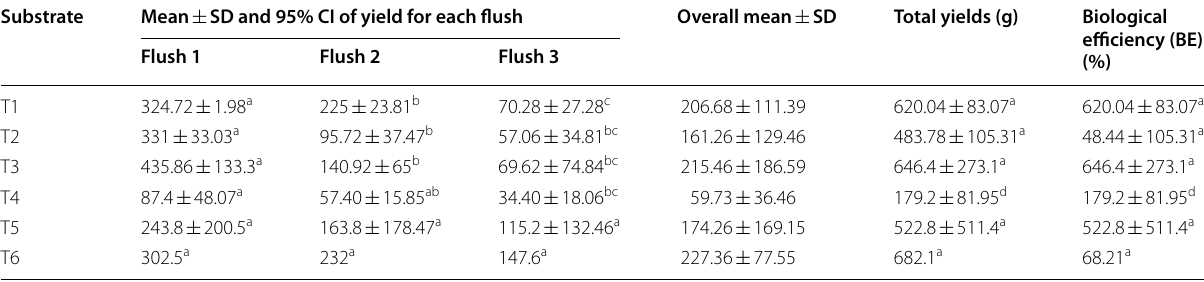
Mean values followed by different superscript letters within a row and columns are significantly different (p < 0.05)